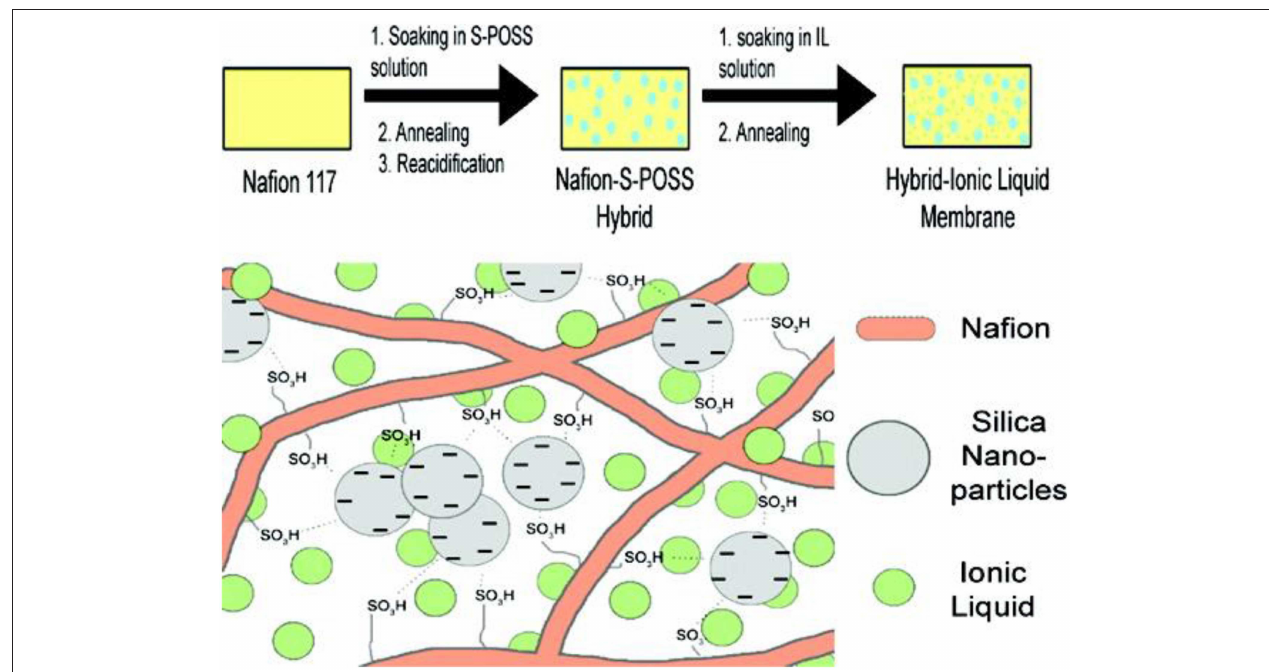
FIGURE 9 | Schematic illustration of the overall procedure for the preparation of Hybrid-Ionic liquid electrolyte. [Reproduction with permission from Subianto et al. (2009) . Copyright © 2009, American Chemical